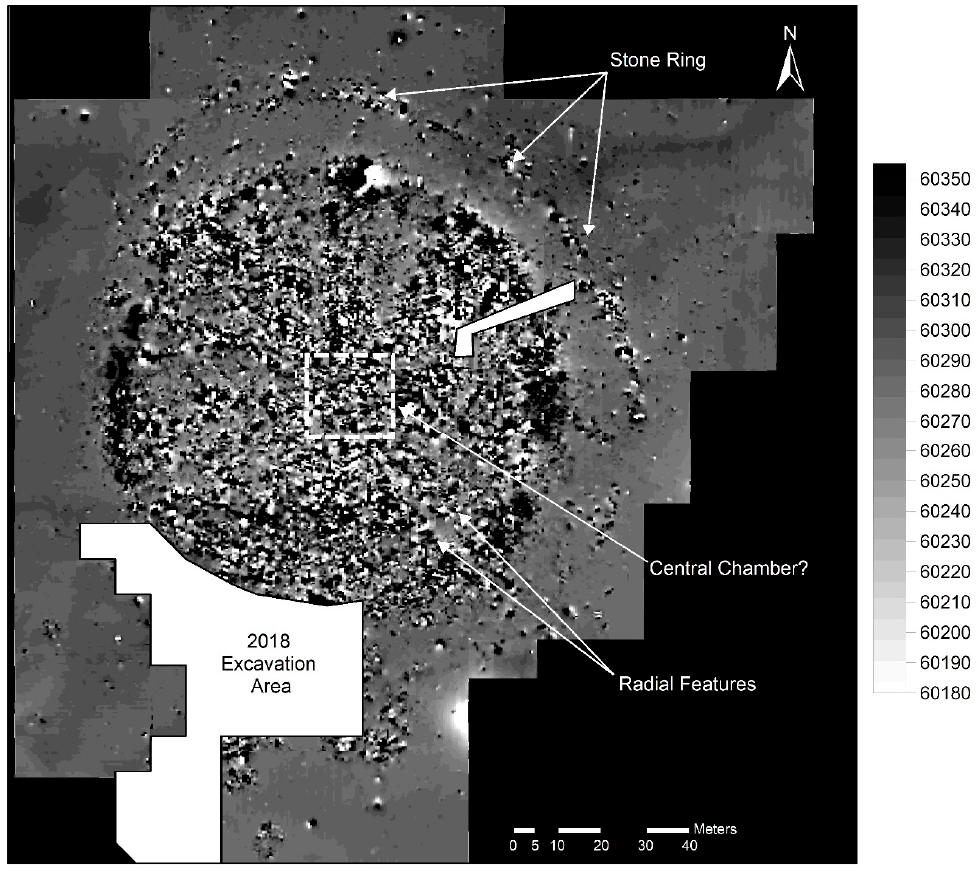
Figure 6. Results of the geomagnetic survey (in nT) with the clearly visible outer stone ring of the burial mound, additional unknown peripheral structures in the south, clear internal radial division of the tomb and a potential central chamber.